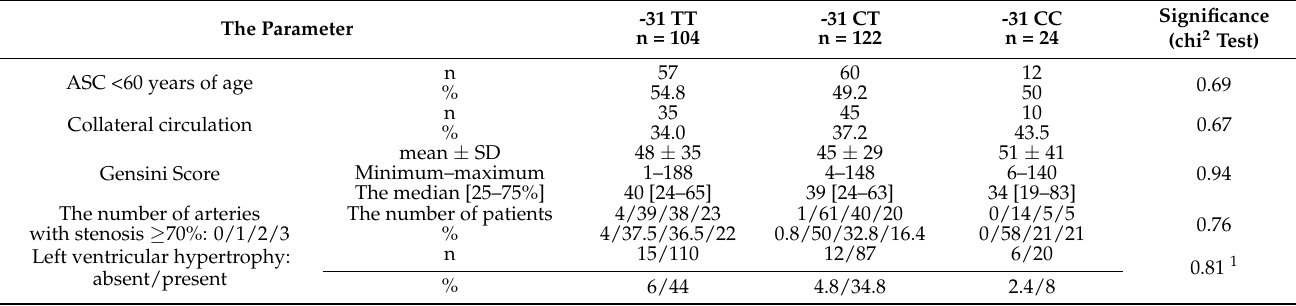
Table 7. The clinical, angiographic, and echocardiographic parameters according to the variant at locus -31.